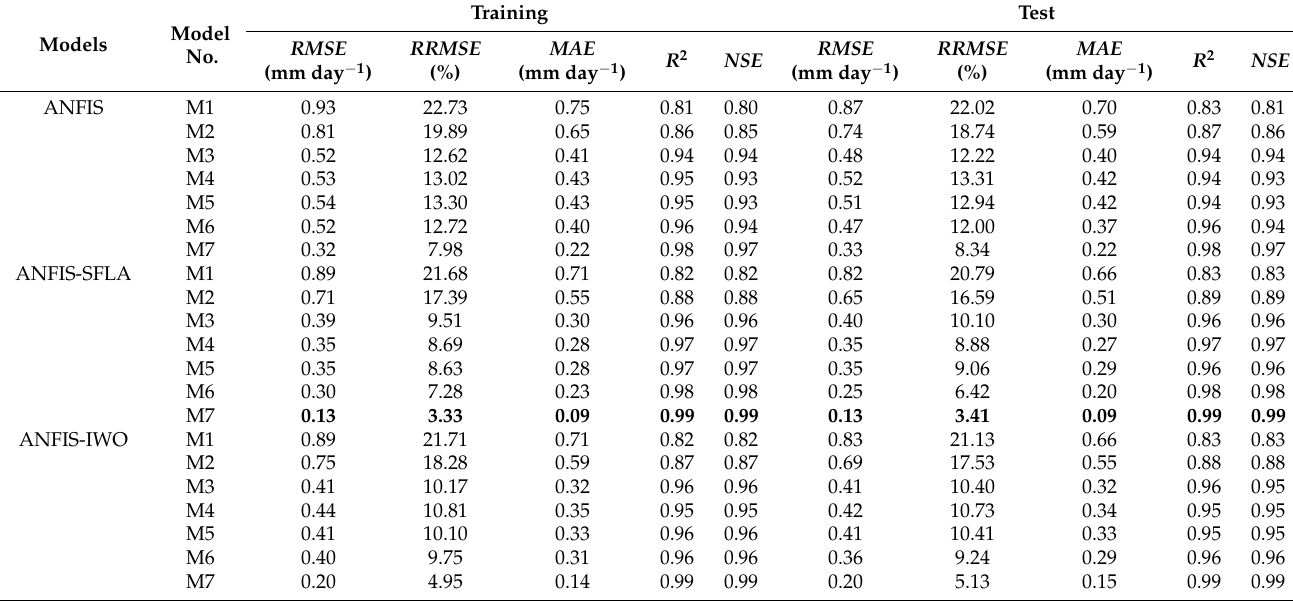
Table 6. The statistical indicators obtained for the classical ANFIS and the proposed hybrid ANFIS-SFLA and ANFIS-IWO models in estimating daily ETo vs. the standard daily ETo calculated with the FAO-56 PM method in the training and test phases (Shiraz station). Model Models